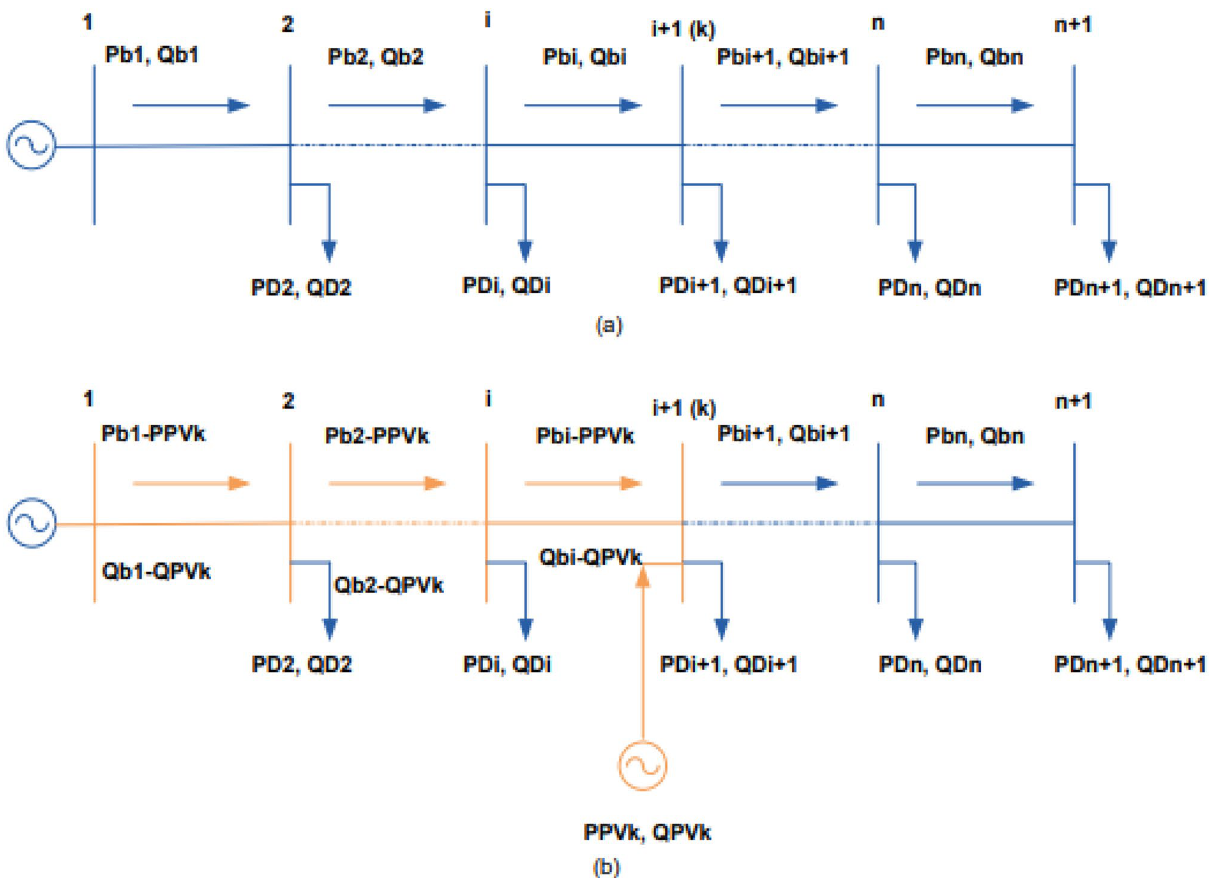
Figure 3. Radial distribution system: ( a ) without PV unit and ( b ) with PV